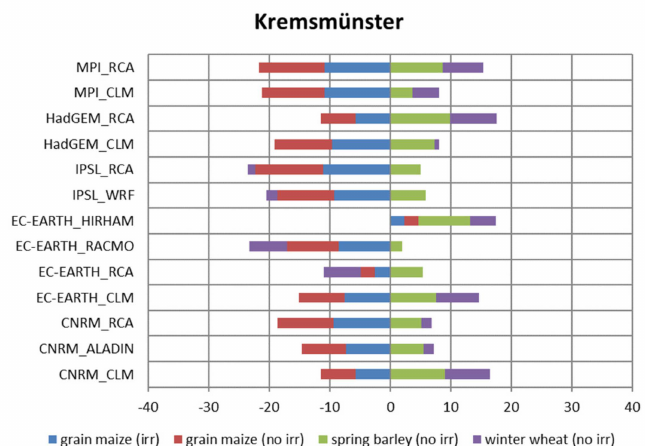
Figure 11. Yield differences (%) in ÖKS15 projections for RCP 8.5 vs. RCP 4.5 for the 2071–2100 period for grain maize (optimal irrigated = irr; rainfed = no irr), spring barley (no irr), and winter wheat (no irr) grown in soil class 2 in Bad